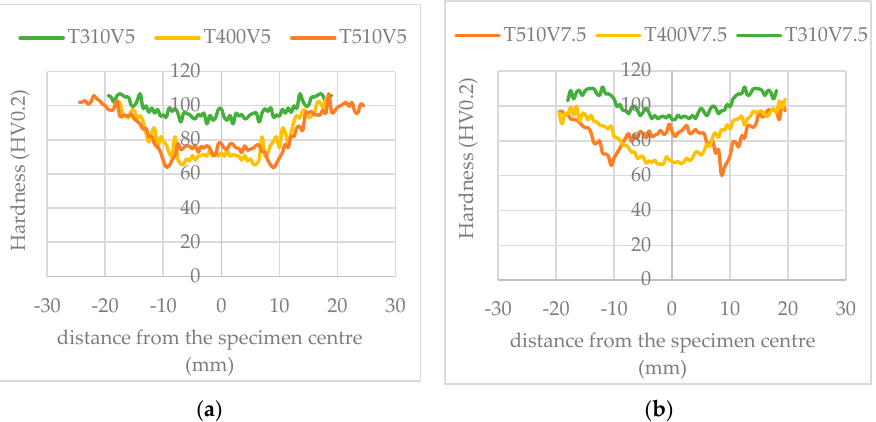
Figure 19. ( a ) Hardness profiles obtained after natural aging (T4) for treatment speed of 5 mm/s; ( b ) Hardness profiles obtained after natural aging (T4) for treatment speed of 7.5 mm/s. By analyzing the micro-hardness values measured at the specimen center, it is con- firmed that, for both treatment speeds, the maximum softening occurs in the tests with a peak temperature of about 400 °C. However, considering the entire hardness profile, the maximum softening occurs in the tests performed with a peak temperature of about 510 °C, even if the position of maximum softening does not coincide with the center of the specimen. To investigate this result, the hardness profiles proposed in Figure 19 were compared with the temperature profiles estimated with the FE model; for example, Figure 20 compares treatment condition T4 with a treatment speed of 5 mm/s and peak temper- ature of about 510 °C. Figure 21 highlights the hardness trend as a function of peak tem- perature obtained by combining the profiles in Figure 20. It is observed that the minimum hardness occurs at a peak temperature of about 430 °C.